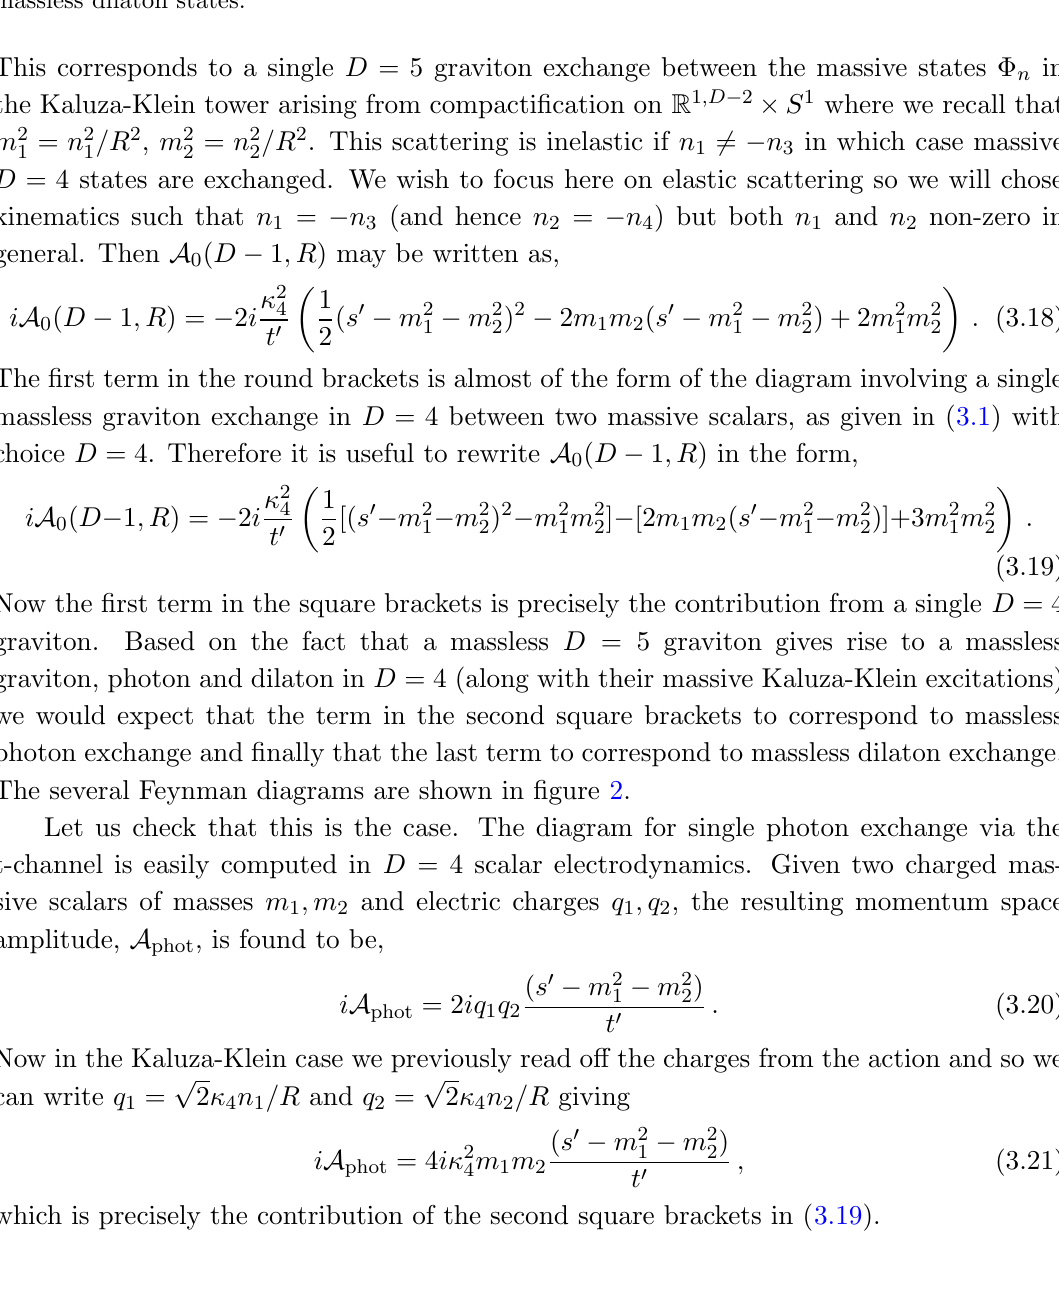
Figure 2 . The various constituent diagrams found in tree-level scalar scattering with graviton exchange on R 1 ;D (cid:0) 2 (cid:2) S 1 when decomposed into seperate dilaton, gauge (cid:12)eld and dimensionally reduced graviton contributions. The solid lines represent scalar states, the dashed line represent gauge (cid:12)elds and the wavy lines represent gravitons. Note that the internal solid lines represent massless dilaton